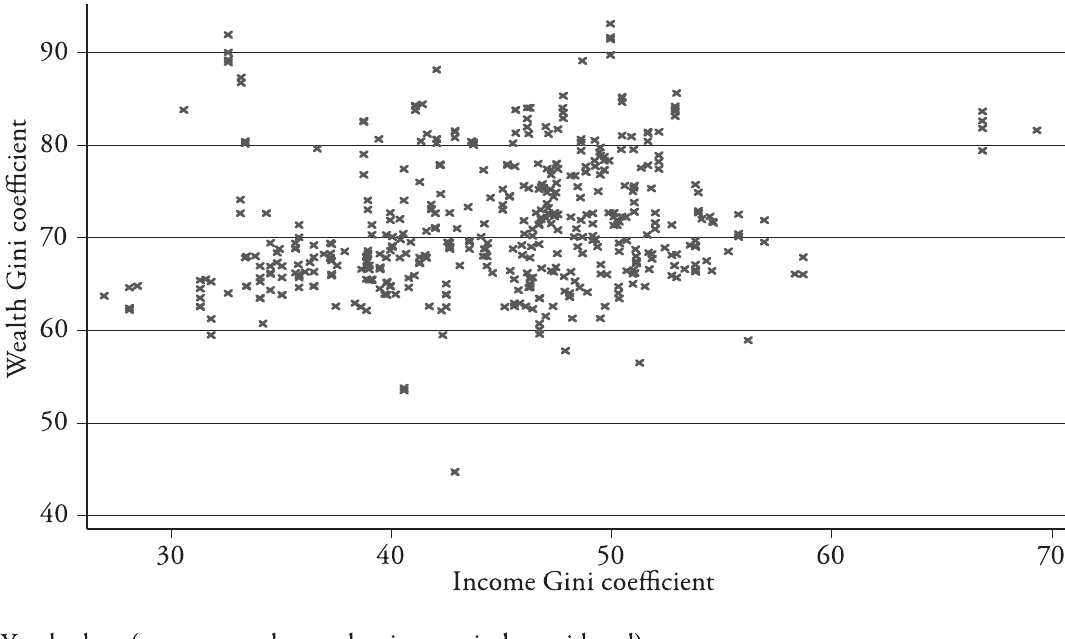
Figure 1: Scatterplot ofWealth Gini vs Income Gini, 116 Countries, 2010-2014